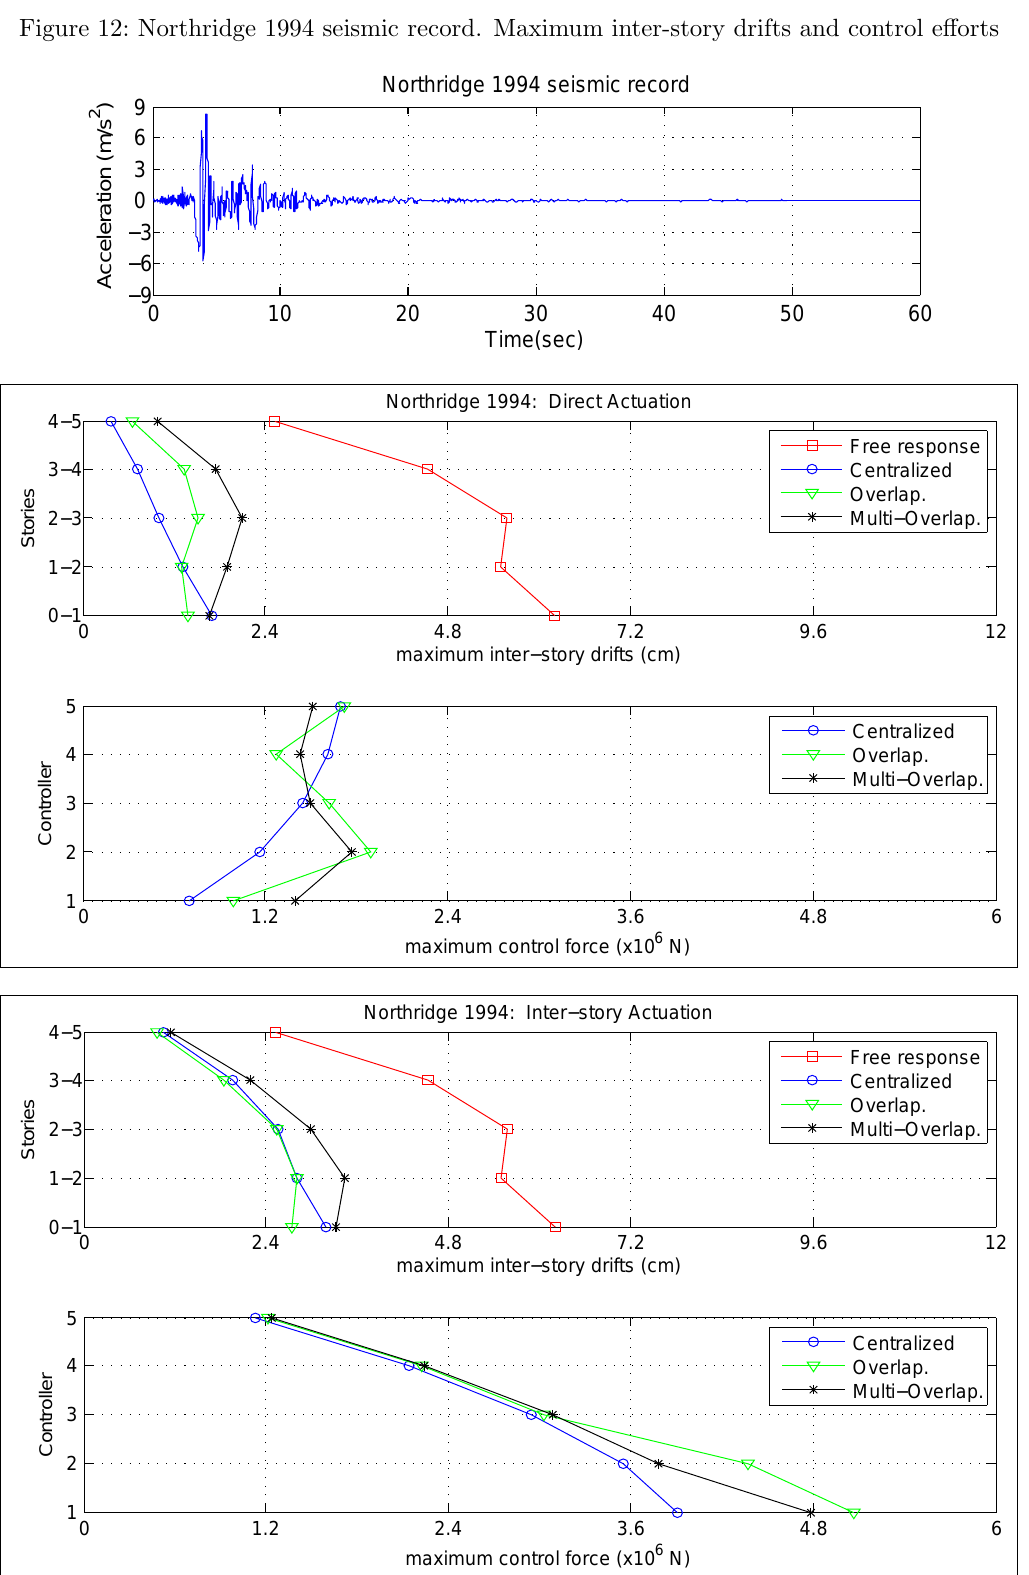
Figure 12: Northridge 1994 seismic record. Maximum inter-story drifts and control